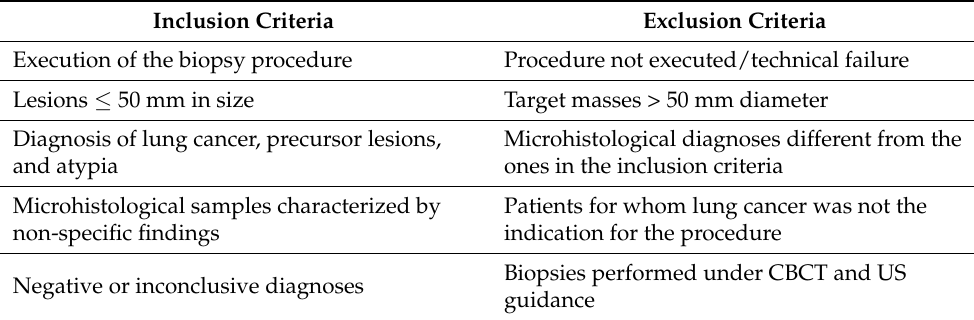
Table 1. Inclusion and exclusion